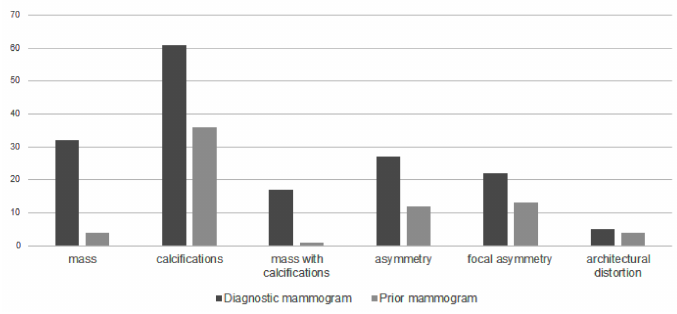
Figure 1. Mammographic features on diagnostic and prior